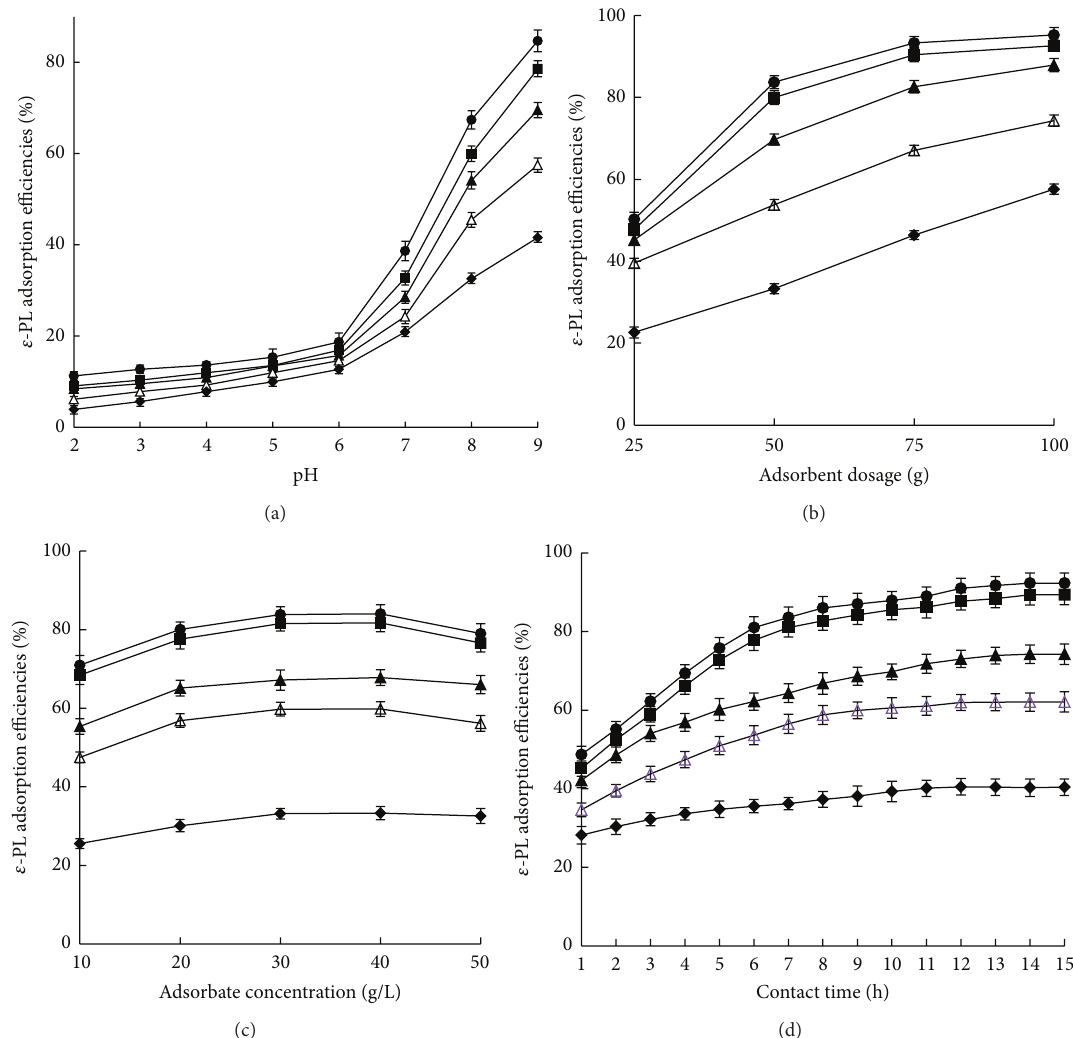
Figure 1: Effects of pH (a), adsorbent dosage (b), adsorbate concentration, (c) and contact time (d) on the 𝜀 -PL adsorption efficiencies of HZD3B ( e ), D155 ( ◼ ), HD-2 ( 󳵳 ), HZD-5 ( △ ), and D113 ( X )